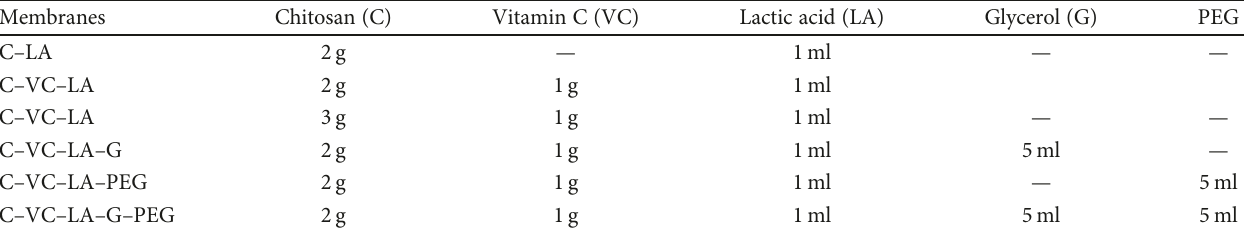
Table 1: Formulations used to make di ff erent composite membranes. The calculation is for the 100 ml solution.